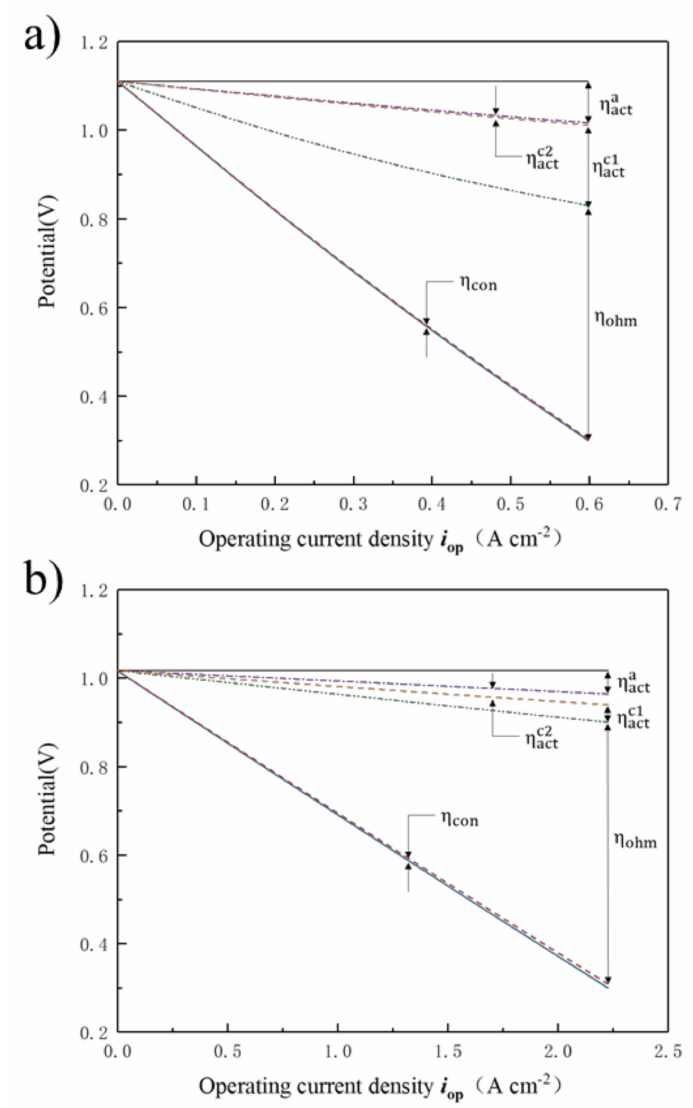
Figure 5. Proportion of each polarization loss in the total overpotential: ( a ) 550 ◦ C and ( b ) 750 ◦ C. In order to more clearly compare the contributions of different overpotentials on the total voltage loss of PCFC at different T , Figure 6 shows the corresponding proportions at the constant output current and voltage cases, respectively. As can be seen from Figure 6a, for i op = 0.5 A cm − 2 , the activation polarization loss (including η a , η c 1 , η c 2 ) goes from act act act 25.0 to 244.2 mV and the ohmic polarization loss goes from 134.4 to 445.5 mV, while the temperature decreases from 1025 K to 825 K. Among them, the activation polarization loss of cathodic oxygen reduction reaction η c 1 is significantly increased from 8.5 to 162.1 mV. act In Figure 6b, for the same operating voltage of 0.5 V, ohmic polarization accounts for the 63.1%, 74.8%, and 82.5% of the PCFC total voltage losses, while T is adjusted to 823, 923, and 1023 K, respectively. With the decrease of temperature, the proportion of cathode activation polarization loss increases from 5.4% to 24.3%. The sharp increase of cathode activation polarization loss at a relevant low temperature is considered to be one of the main factors that contributes to the performance degradation of